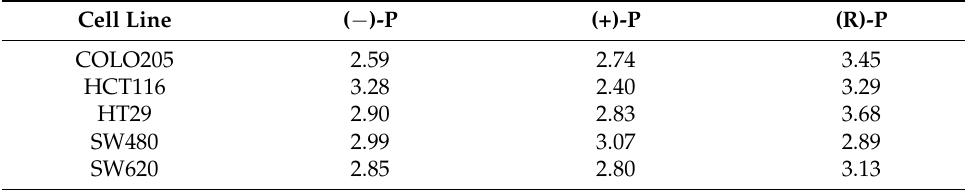
Table 2. Selectivity index of (+)-P, ( − )-P and (R)-P against HFFs.